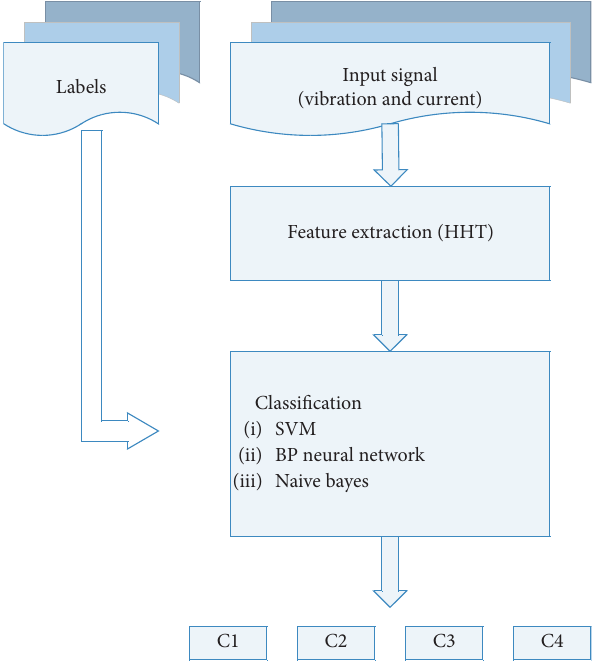
Figure 6: A generalized framework of the proposed